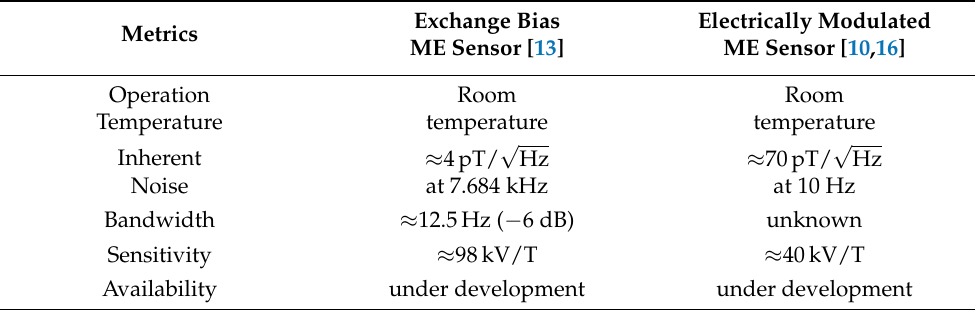
under development under